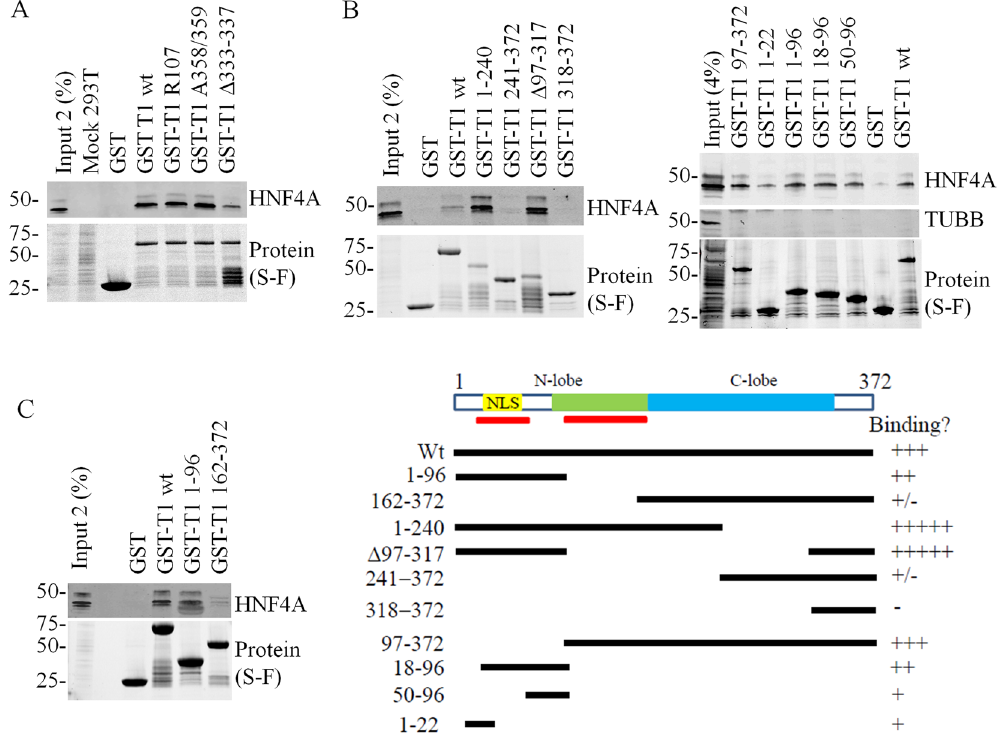
Figure 6. Mapping of the TRIB1 interface associating with HNF4A. Recombinant TRIB1 or fragments thereof, harboring the indicated mutations or deletions were incubated in the presence of HNF4A-expressing HEK293T lysates. A , Interaction between TRIB1 and HNF4A does not require MEK1 or COP1 binding interface, nor is it altered by a gain-of-function mutation. B and C , Multiple TRIB1 epitopes interact with HNF4A in vitro . Bound material was isolated and analyzed by Western blot. Corresponding protein baits were imaged prior to transfer using Stain Free gels. Schema illustrates truncations employed and their relative binding to